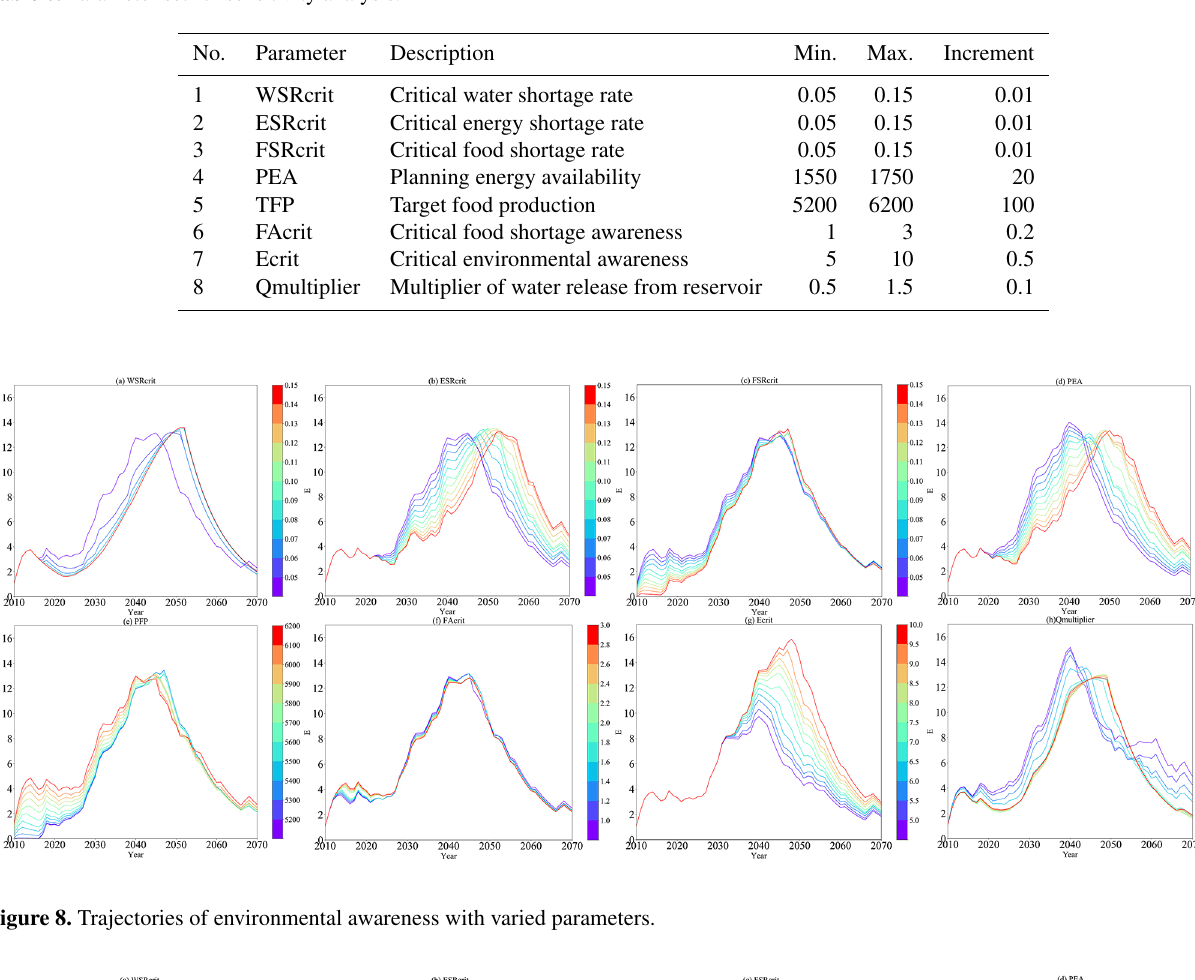
Table 6. Parameter set for sensitivity analysis.